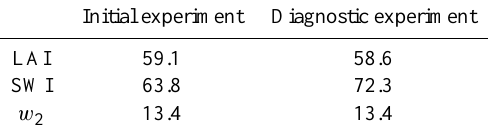
Fig. 8. Seasonal LAI diagnostics of background errors for all five options used in this study calculated over the 7-year period (2001– 2007). The estimated (diagnosed) values are in black, the specified values in gray. Table 3. Comparison of the LDAS performance (in %) calculated over the 7-year period (2001–2007) when using the specified (ini- tial experiment) and diagnosed (diagnostic experiment) values for the root-zone soil moisture and SWI. Option 3 for LAI error speci- fication is used in both experiments.